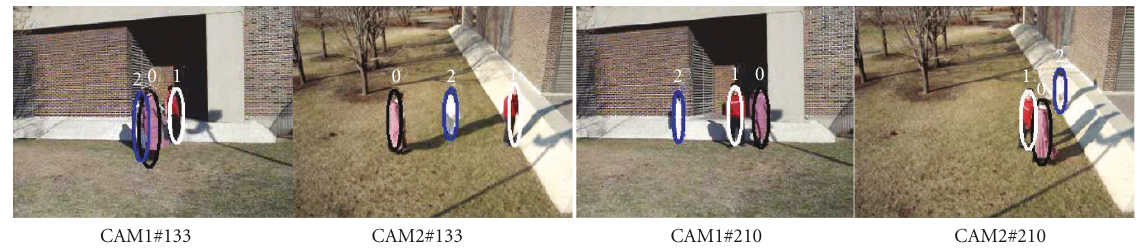
Figure 11: Tracking results of the proposed BMCT on the outdoor videos Campus .